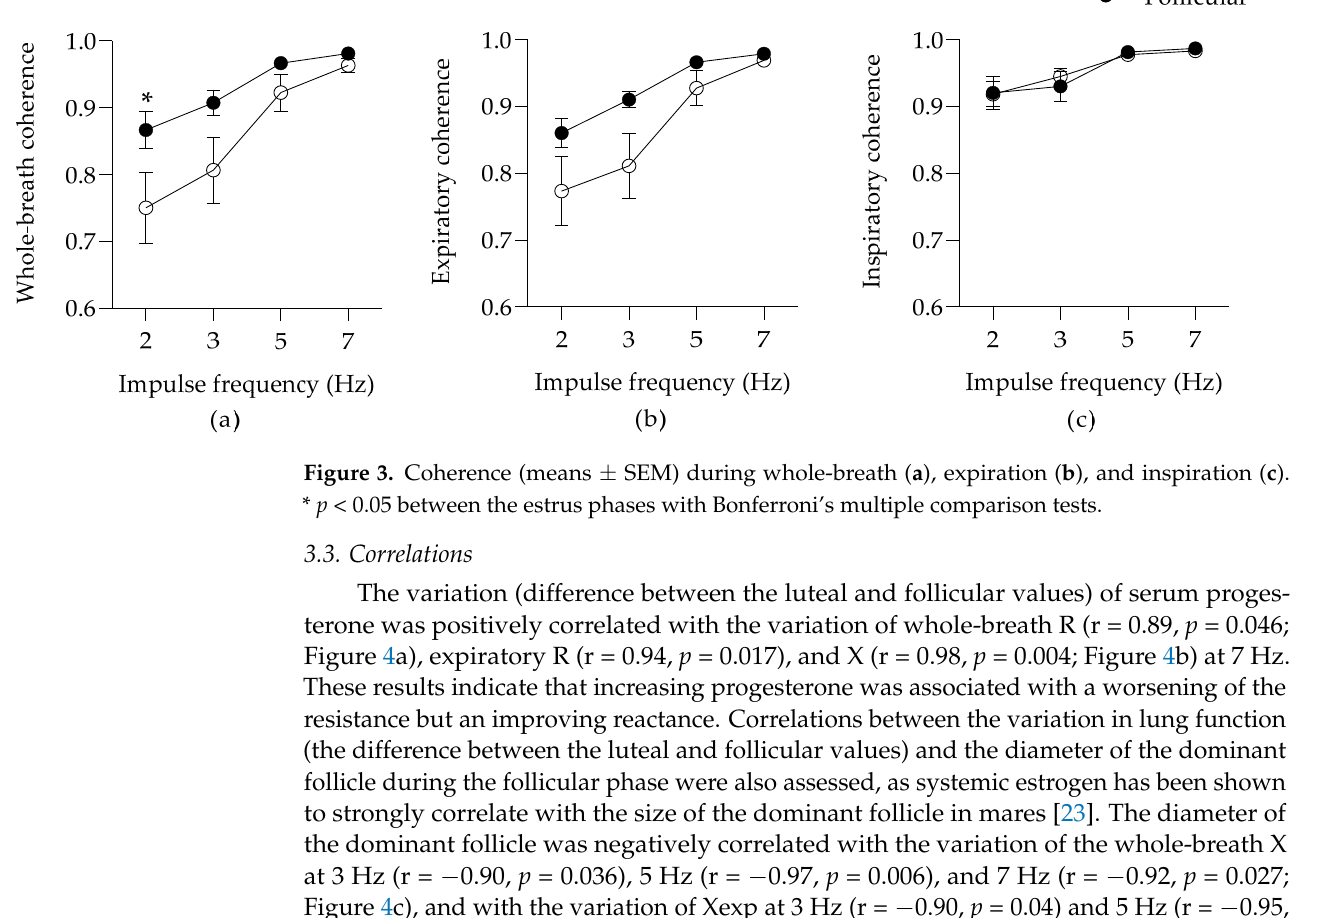
Figure 2. Pulmonary reactance (means ± SEM) during whole ‐ breath ( a ), expiration ( b ), and inspi ‐ ration ( c ).